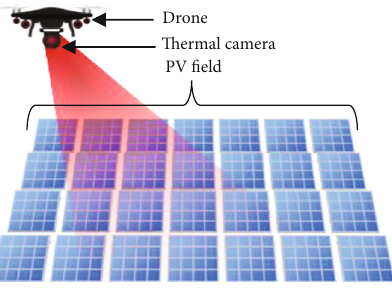
Figure 1: Control photovoltaics fi eld using thermal camera on drone.